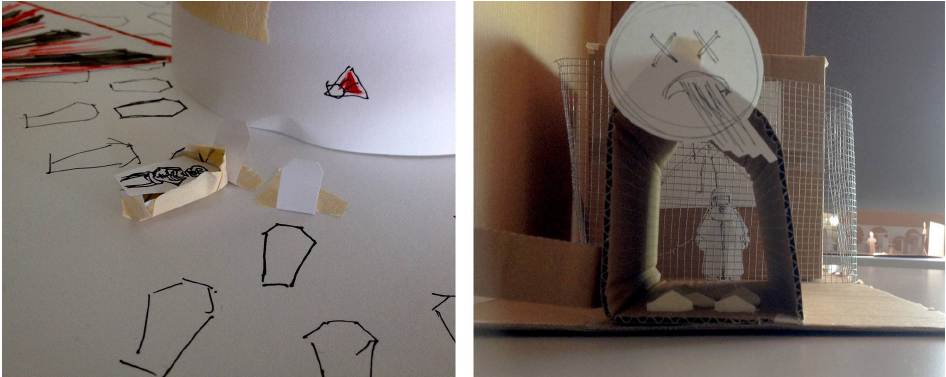
Figure 8. Student responses to in-class exercise duplicating the WIPP brief.